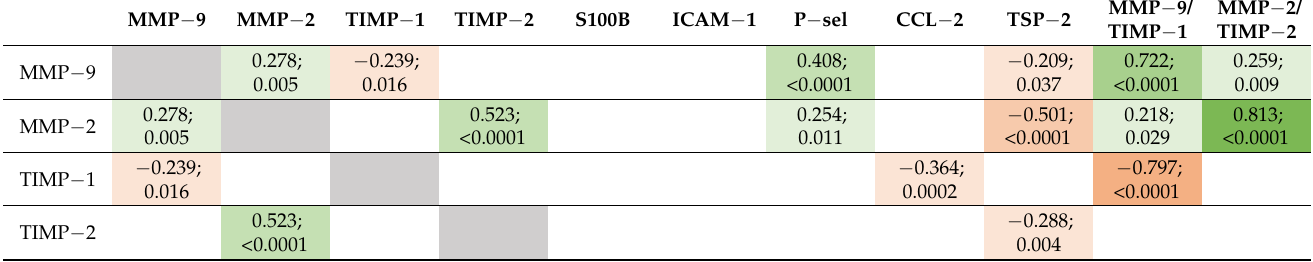
Table 4. Correlations between the levels of the BBB-associated proteins. Upper line—correlation coef- ficient; lower line—level of significance. The values are given only for correlation coefficients ≥ 0.2. Cells are colored according to the color legend depending on the correlation